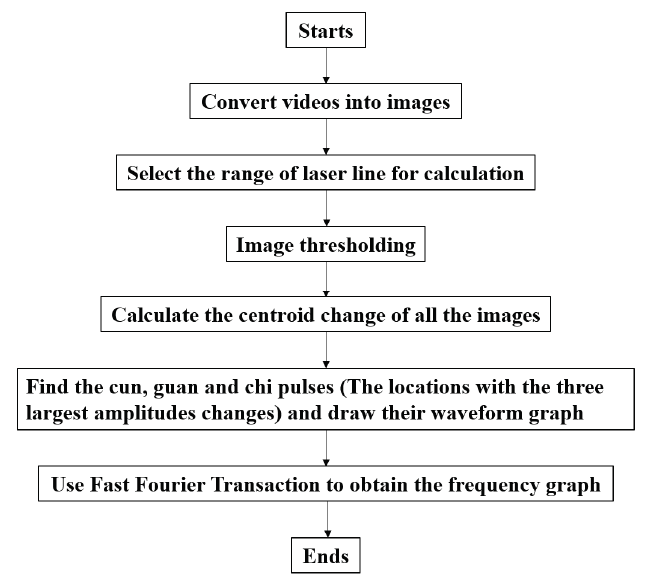
Figure 9. Program flow chart.